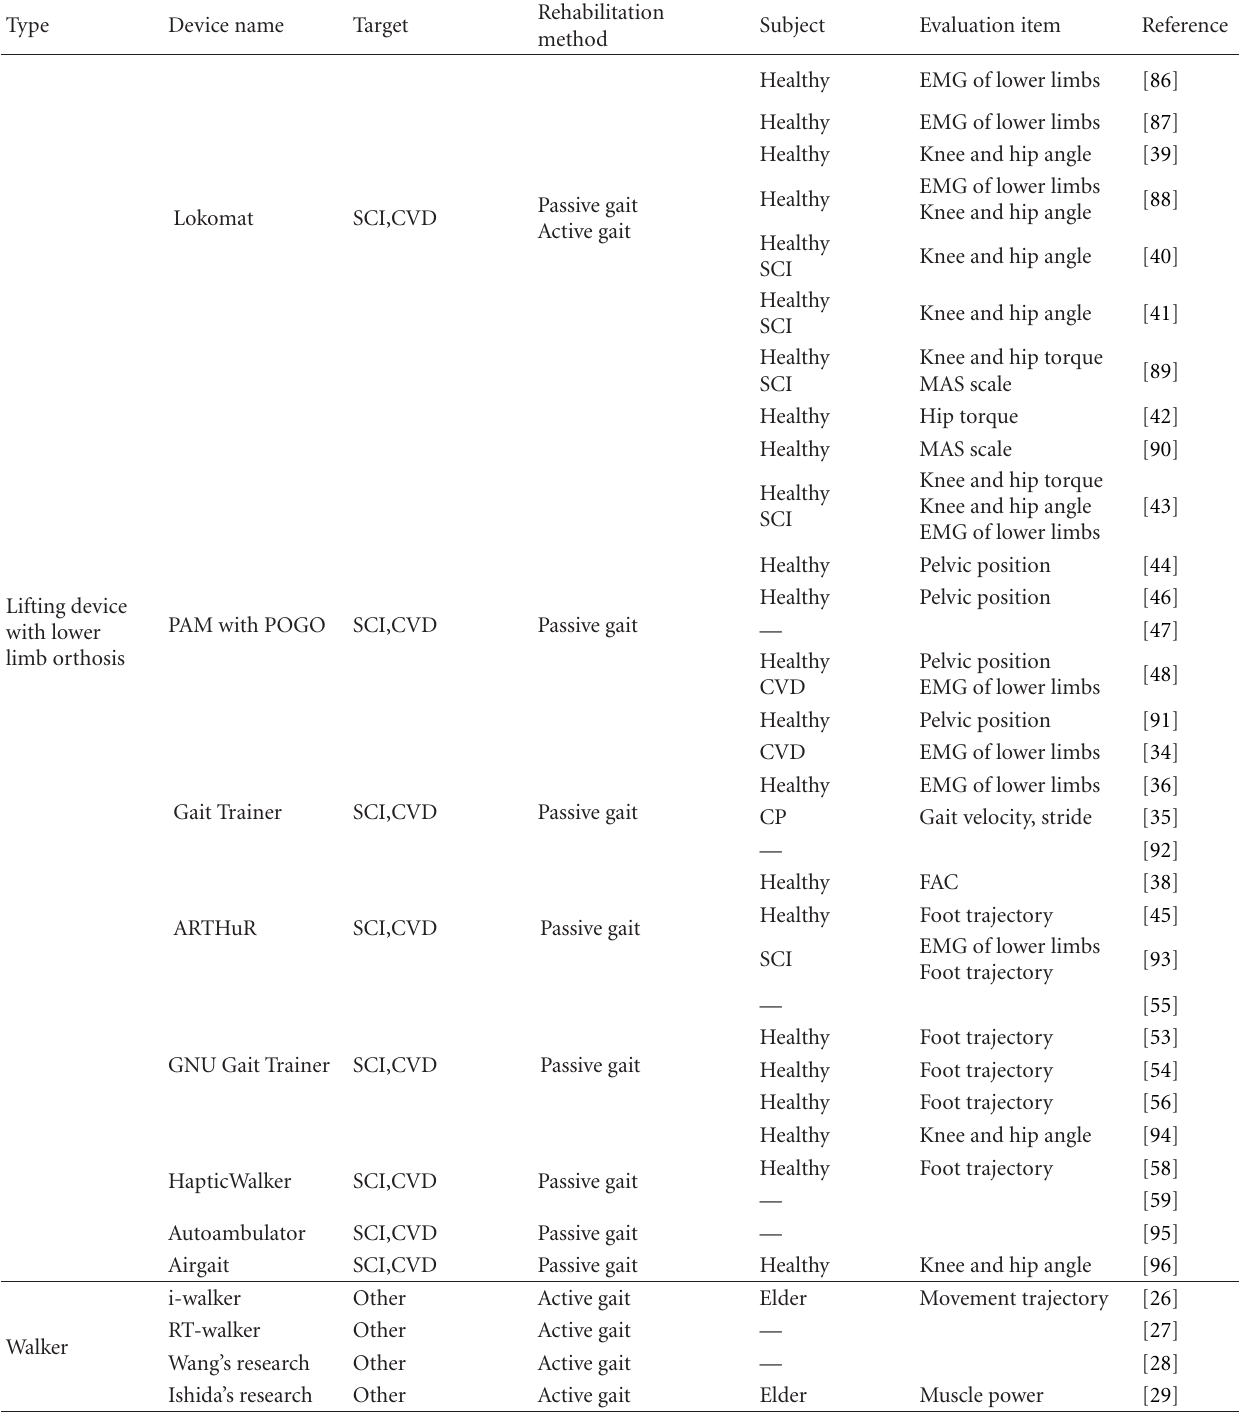
Table 2: Reference about gait rehabilitation device number